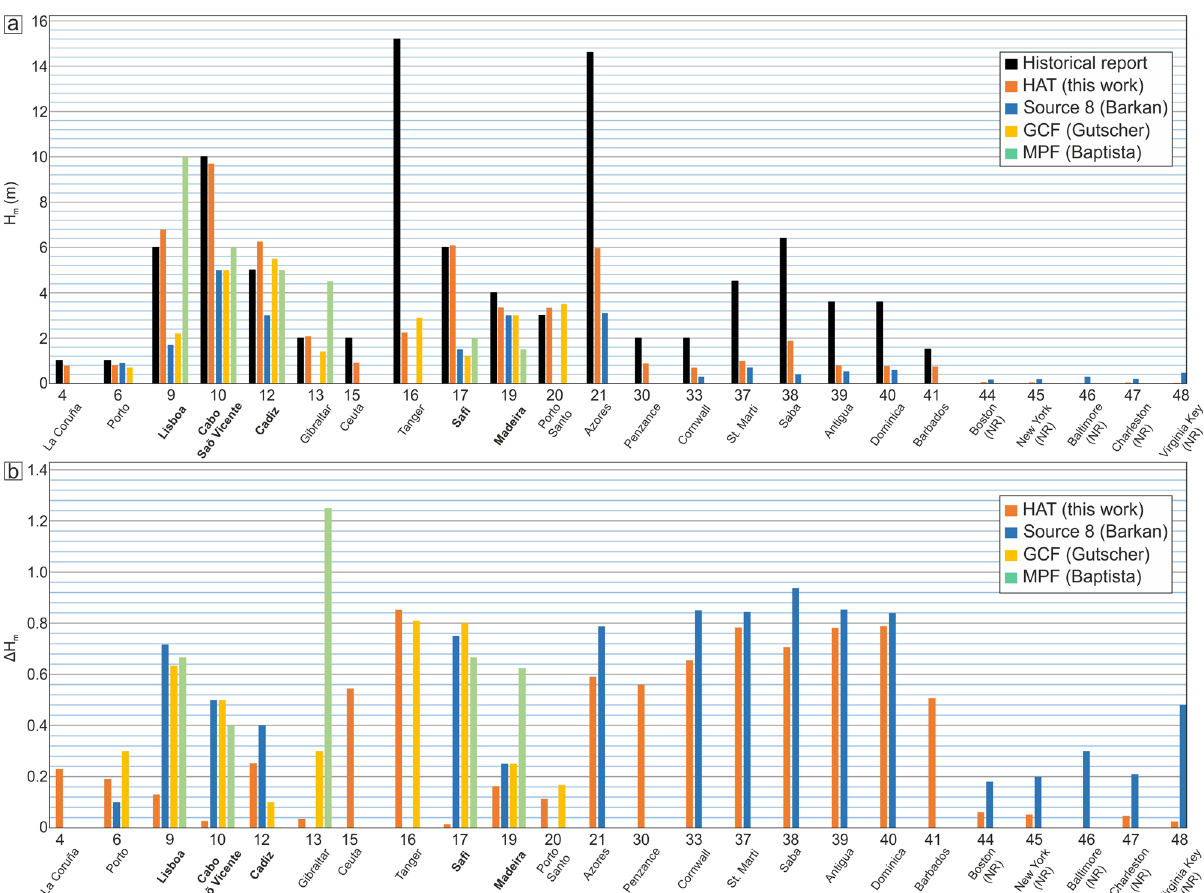
Fig. 5 Comparative between the wave height of the tsunami simulations and the run-up of the 1755 tsunami historical reports. a Graph showing the run-up of the 1755 Lisbon tsunami speci fi ed on historical reports 10 – 14,16 – 19,27,45 – 48 ( H obs in black) and the maximum wave height ( H calc ) obtained from the m m tsunami simulations of different tectonic structures: the Horseshoe Abyssal plain Thrust (HAT, in orange), the Source 8 27 (in blue), the Gulf of Cadiz Fault 26 (GCF, in yellow) and the Marques de Pombal Fault 11 (MPF, in green) (see Supplementary Table 2). b Graph showing the relative variation ( Δ H m ) at different locations between the reported run-up ( H obs ) and the H calc speci fi ed in a for each tsunami simulation. In bold are labelled locations with m m information available for comparison from the four tsunami